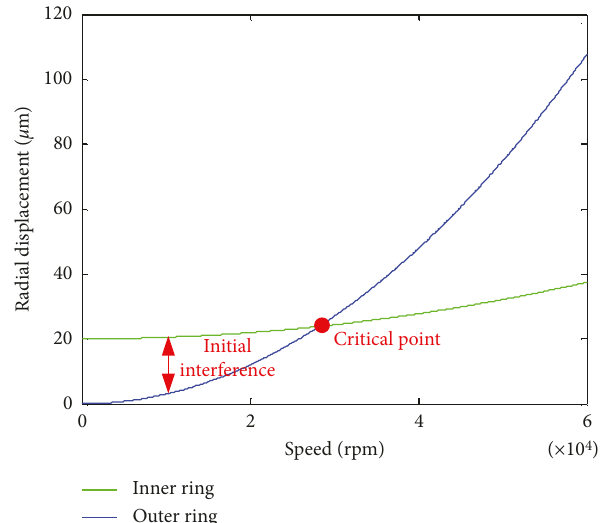
Figure 6: Relationship between radial displacement and speed.